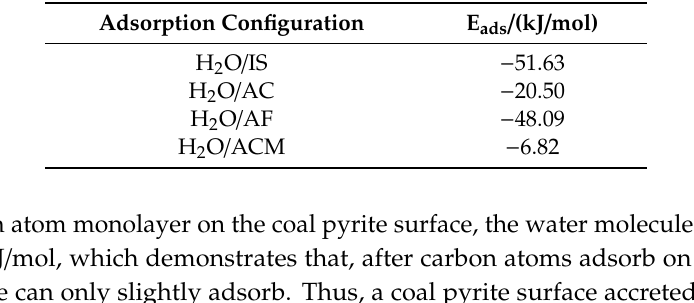
Table 2. E ads of H 2 O on di ff erent pyrite